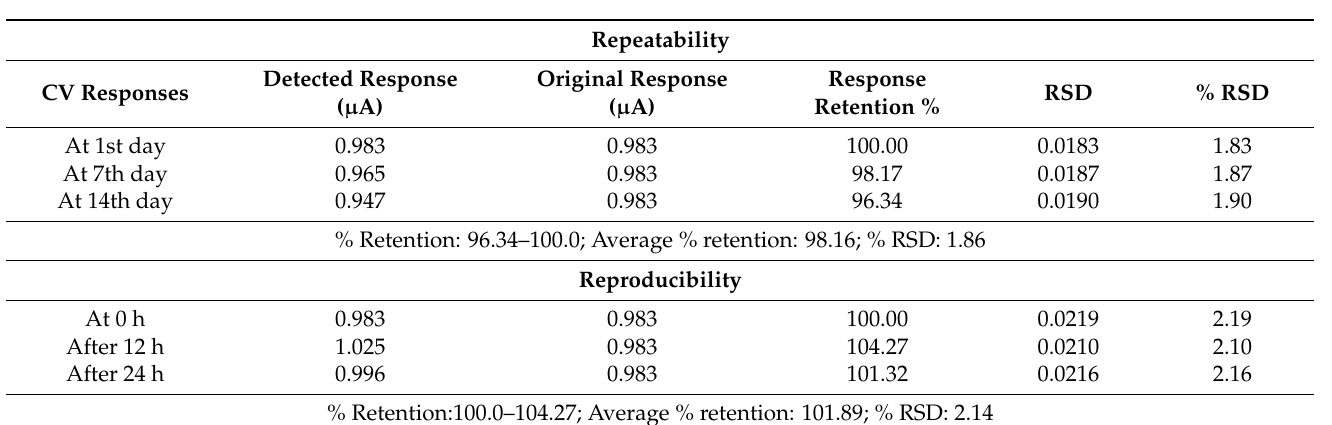
Table 4. Details about the stability of the